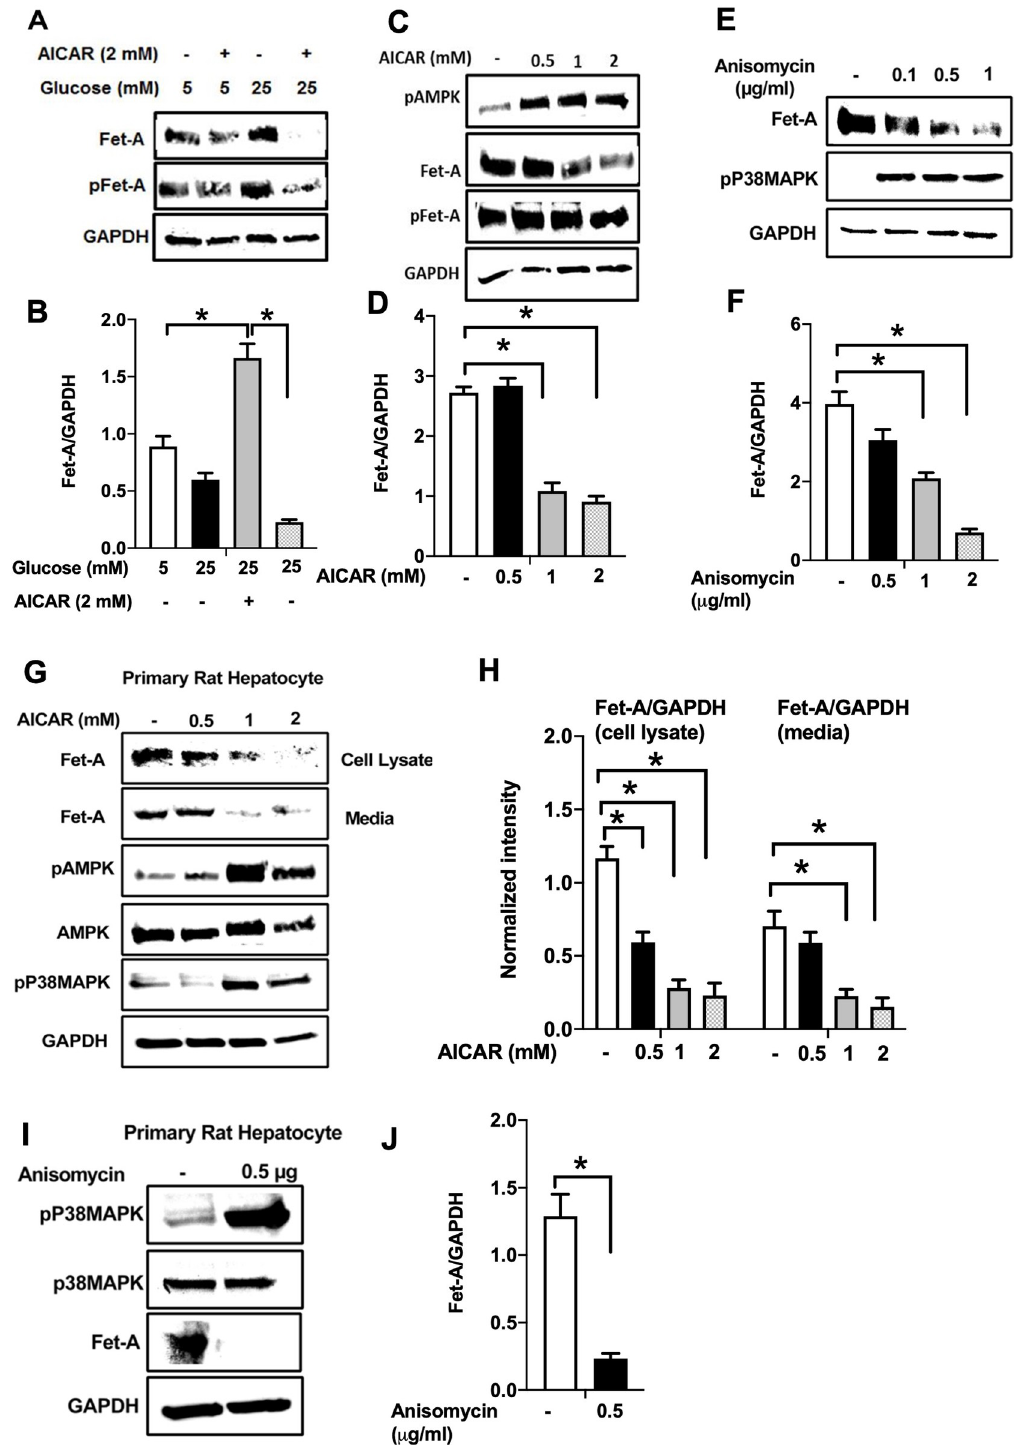
Fig 4. Effect of AICAR or anisomycin treatment on Fet-A expression in Hep3B cells and primary rat hepatocytes. [A] Hep3B cells were incubated in low or high glucose media with or without AICAR for 12 hours, and cell lysates were subjected to immunoblotting for Fet-A and phosphorylated Fet-A (n = 4). [B] High glucose-mediated changes in Fet-A level in Hep3B cells was expressed as a ratio to GAPDH. [C] Hep3B cells were incubated with different concentration of AICAR for 12 h and cell lysates were analyzed by Western blotting for indicated proteins (n = 3). [D] Effect of AICAR on Fet-A level in Hep3B cells